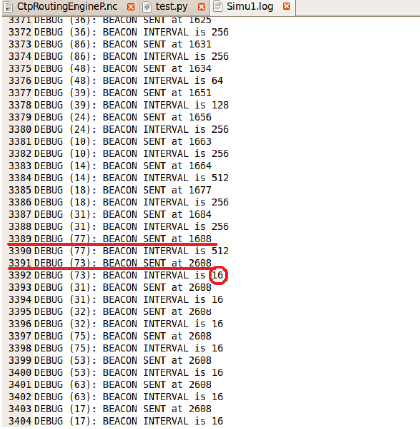
Figure 7: Simulation result of dynamic routing mechanism 1.